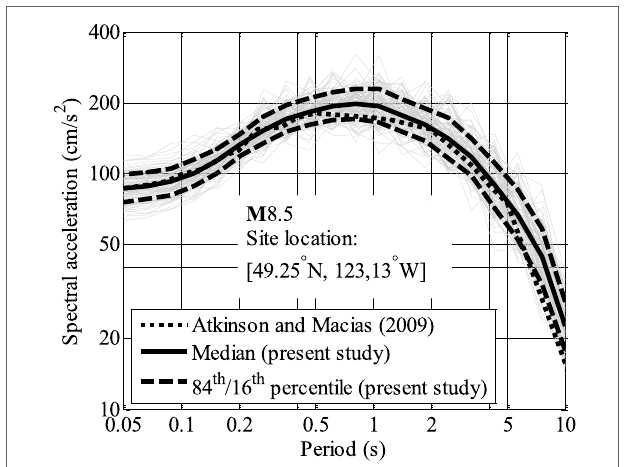
FIGURE 2 | Comparison of the average response spectrum given by Atkinson and Macias (2009) and finite-fault simulations using parameters shown in Tables 1 and 2